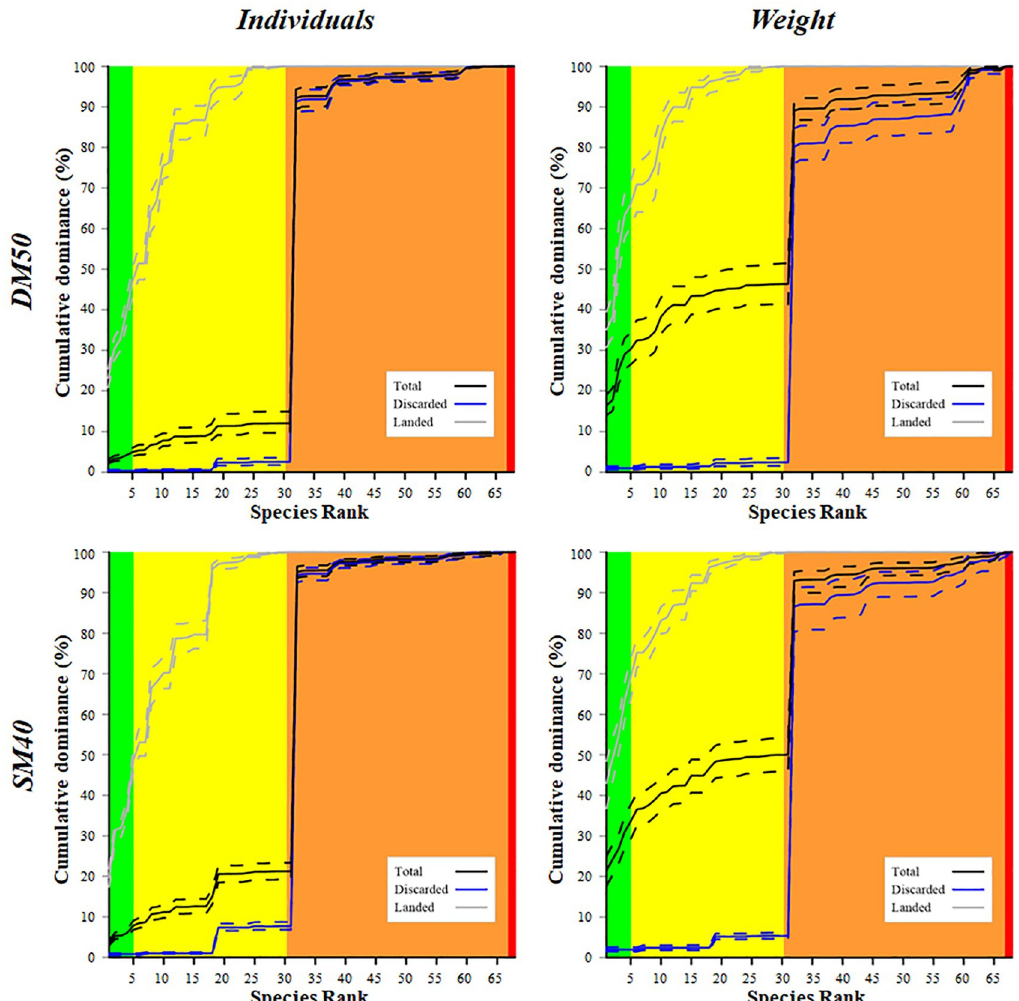
Fig 2. Cumulative species dominance in the catch of the 50 mm diamond mesh codend (DM50, above) and 40 mm square mesh codend (SM40, below). The curves (solid lines) with 95% CIs (dotted lines) represent the cumulative species dominance for the catches in both number of individuals (left) and weight (right). The green, yellow, orange and red areas represent the target species, the bycatch species of commercial value, the species of no commercial value and the protected species,